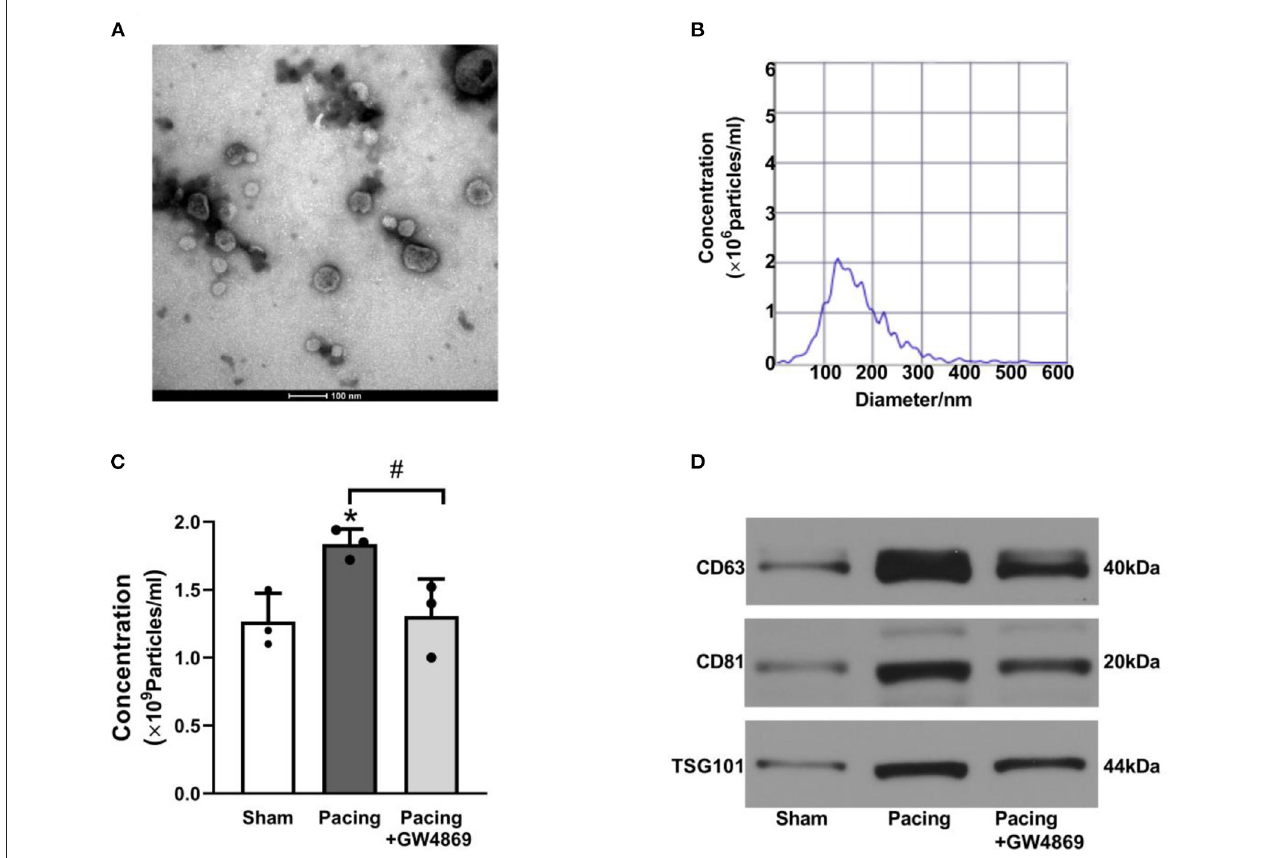
FIGURE 2 | Characteristics of plasma exosomes in a canine model of AF. (A) Representative electron microscopy image of exosomes isolated from plasma ( n = 3, scale bar, 100nm). (B) Representative NTA picture of the exosome size range and concentration ( n = 3; dilution ratio, 1:500). (C) The concentration of plasma exosomes according to NTA analysis and plasma volume. (D) Representative western blotting images of the exosome markers CD63, CD81, and TSG101. * P < 0.05 vs. the sham group. # P < 0.05 vs. the pacing group. AF, atrial fibrillation; NTA, nanoparticle tracking analysis.